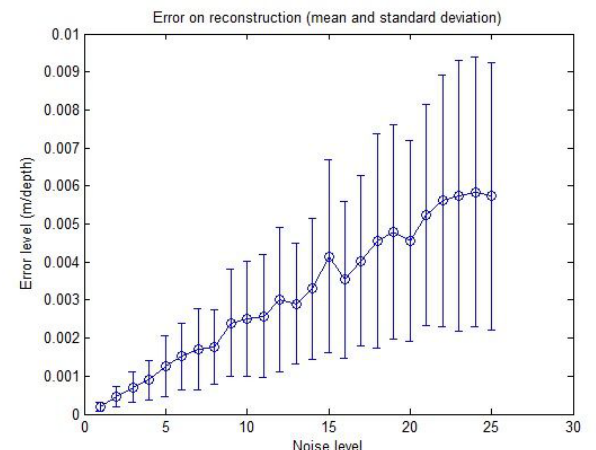
Figure 9. Reconstruction error with respect to the noise level. The error is in meters relative to the point depths r . The mean and standard deviation of the RMSE, over 50 reconstructed points, are shown.